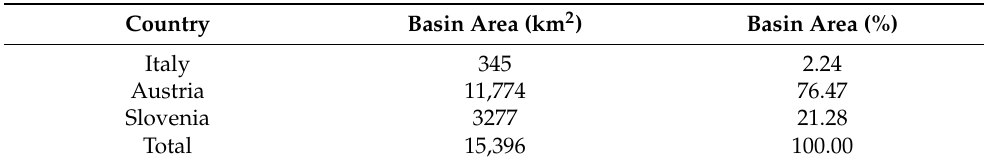
Table 1. Basin area per country upstream from